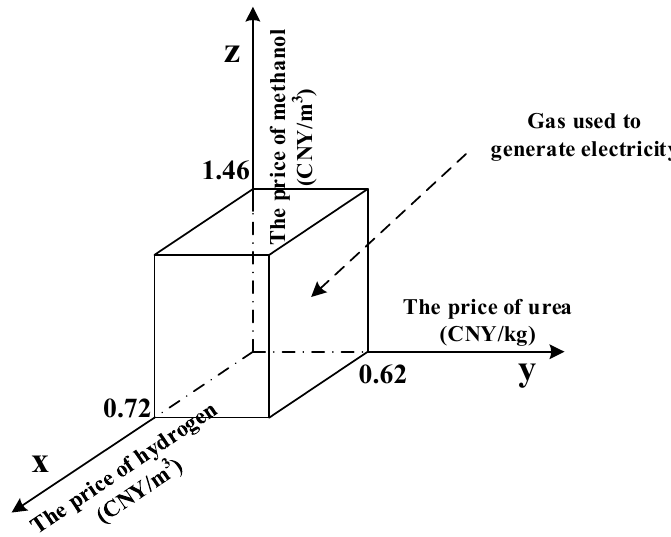
Figure 6. The choice between generating electricity and chemical utilization of coke oven gas (COG).